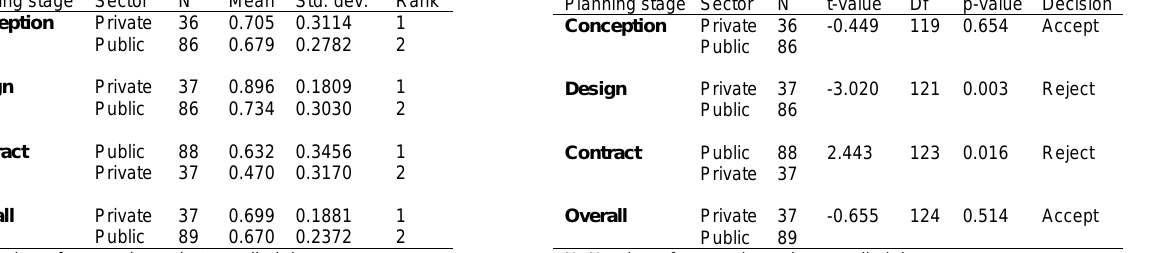
Table 2: Ranking analysis by planning stage Planning stage Sector